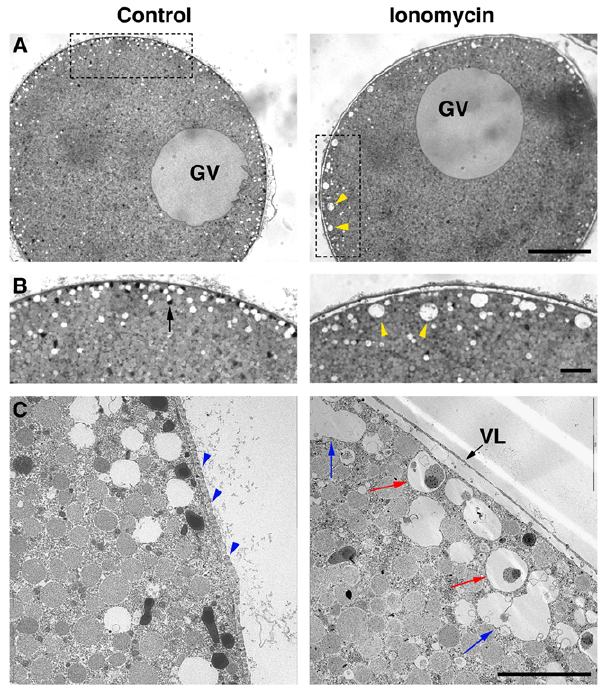
Figure 2. Morphological changes in the cortex of the starfish oocytes exposed to ionomycin. A. aranciacus oocytes at the GV stage were fixed in glutaraldehyde after 5 min incubation with 5 m M ionomycin in natural seawater. ( A ) Bright field view in the light microscope. GV=germinal vesicle. Scale bar=50 m m. ( B ) The magnified views of the dot-lined rectangular areas in panel A. The same large vesicles in panel A were marked with yellow arrowheads. Note that cortical granules that appear as dark vesicles sized about 1 m m (arrow) had largely disappeared in the oocytes briefly exposed to ionomycin. Scale bar=10 m m. ( C ) TEM image of the same batch of oocytes incubated in the absence (left) or present of 5 m M ionomycin for 5 min. Blue arrowheads indicate microvilli in cross-section. Red arrows indicate the white vesicles engulfing electron-dense cortical granules. Blue arrows, white vesicles at fusion; Scale bar=10 m m.